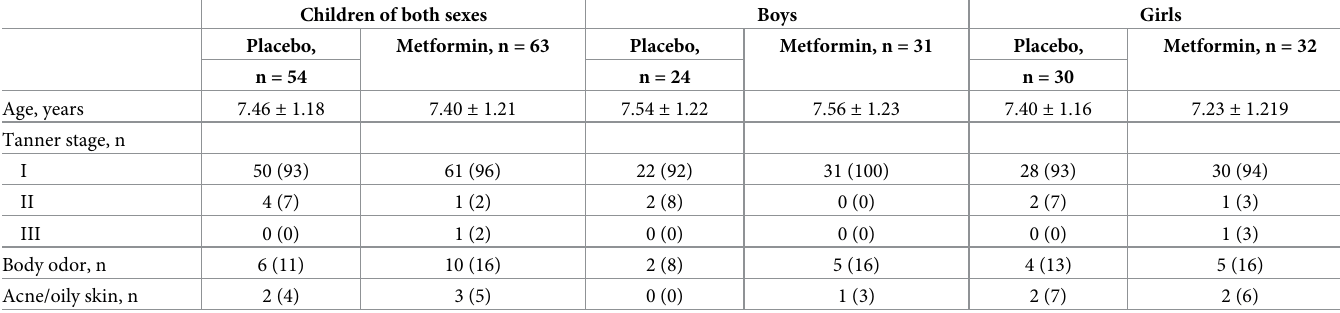
Table 1. Age, Tanner stage and signs of puberty in the children (n = 117) at inclusion at 5–10 years of age. Children of both